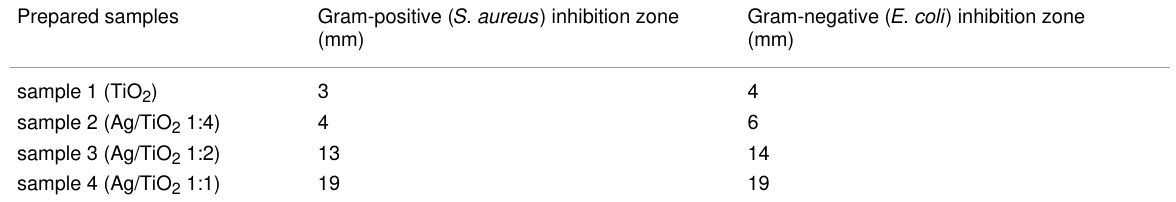
Table 1: Inhibition zones against Gram-positive and Gram-negative bacteria.